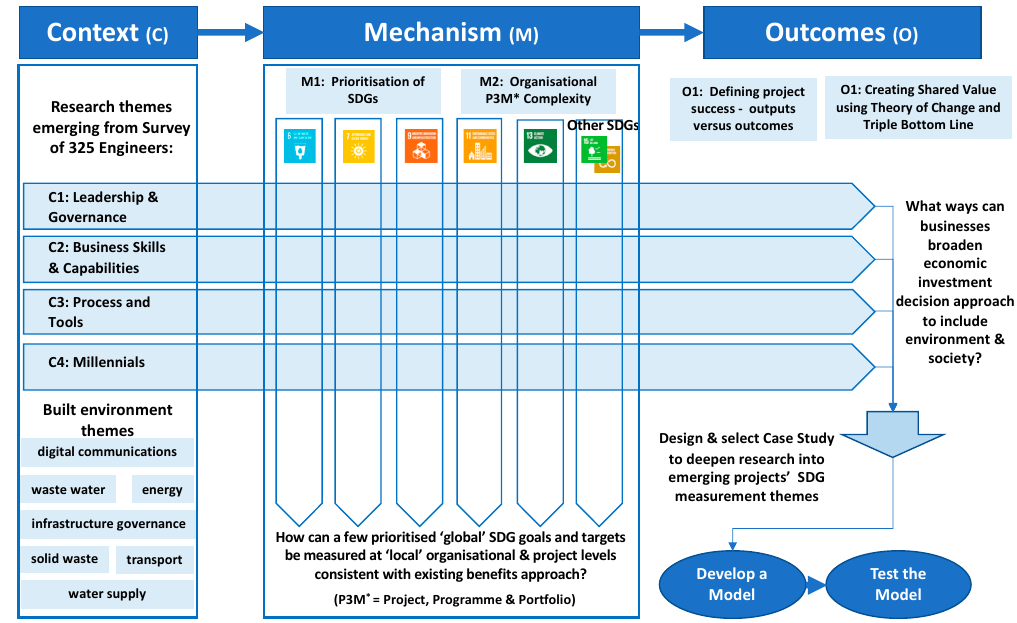
Table 3. Summary of conceptual development of a future prototype model for SDG measurement, based on the survey results in this study, including questions & sub-questions, supporting literature and corresponding concepts.